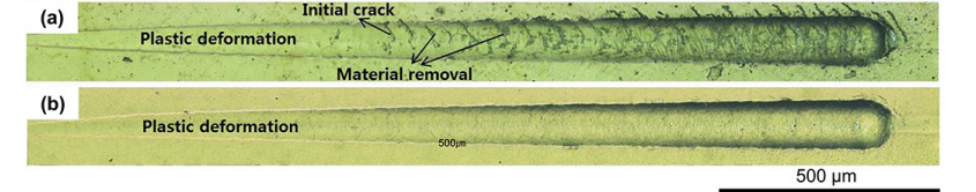
Figure 11. Progressive scratch test marks of the PVD-coated ( a ) and CVD-coated ( b ) Co–Cr alloy (maximum load of 30 N and length of 2 mm).